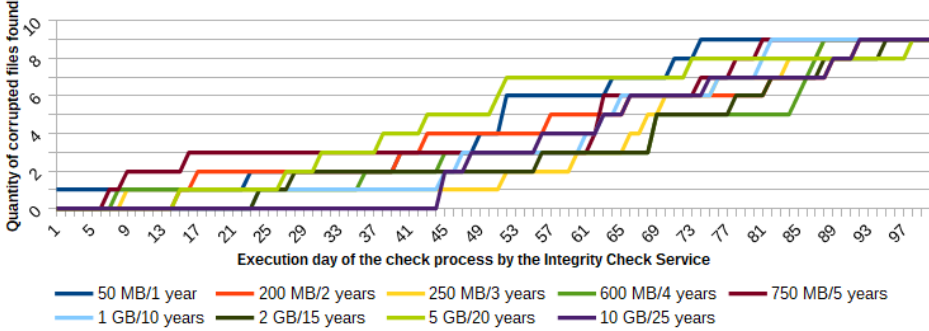
Figure 9. Comparison of the periods required to identify corrupted files by file size and storage time.